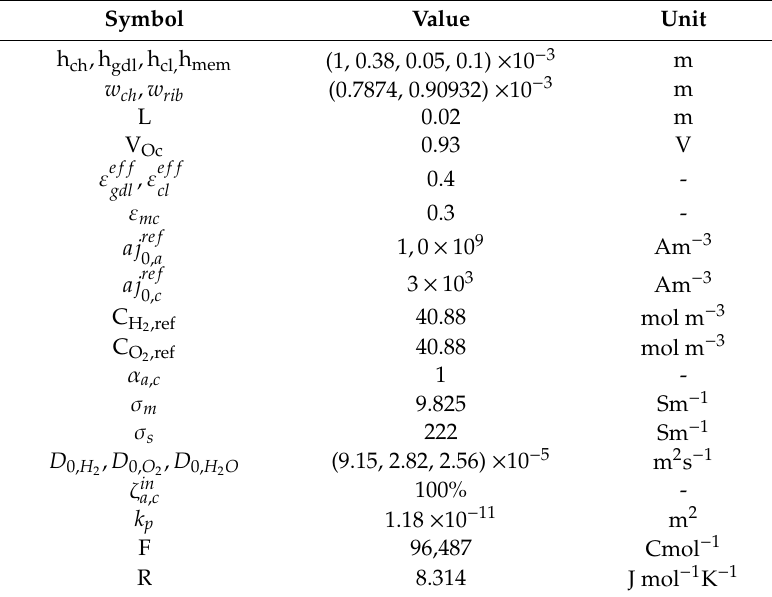
Figure 1. Schematic of 3D single-channel HT-PEMFC. Table 1. Geometry and main physical parameters.